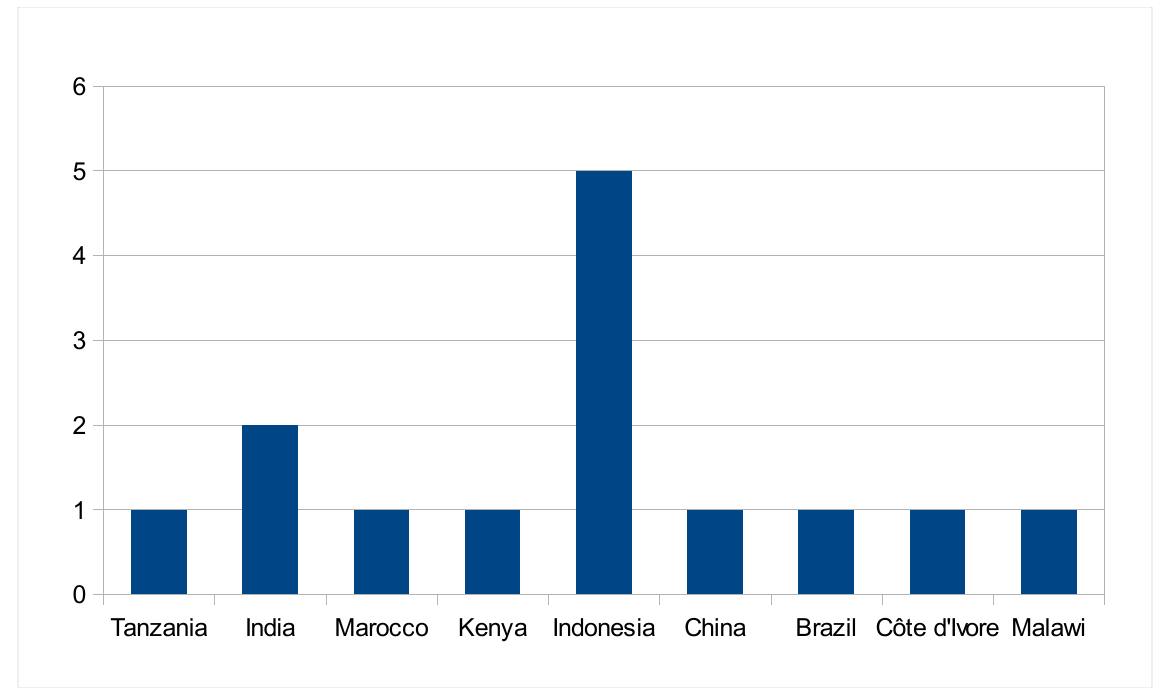
Figure S1. Distribution of the 14 reviewed studies according to country of